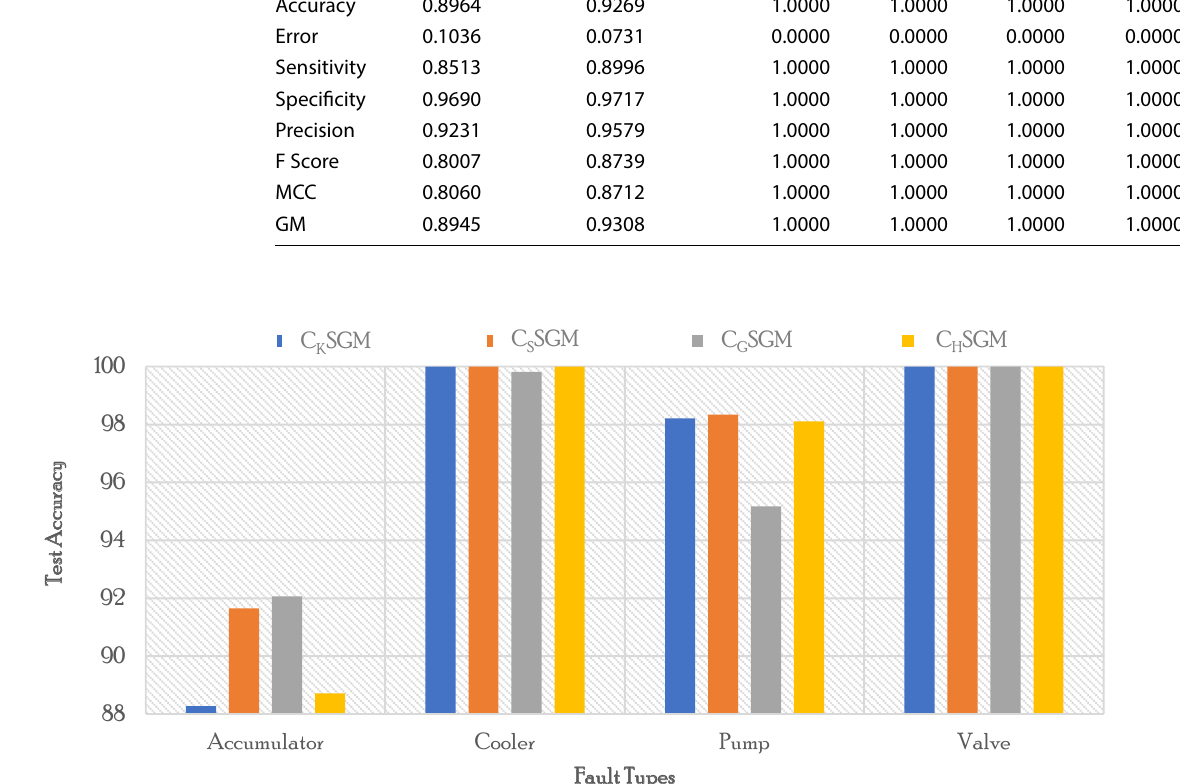
Table 13 Classification performance of GWO-MLP, SMOTE-GWO-MLP and CLUST- SMOTE-GWO-MLP on valve condition